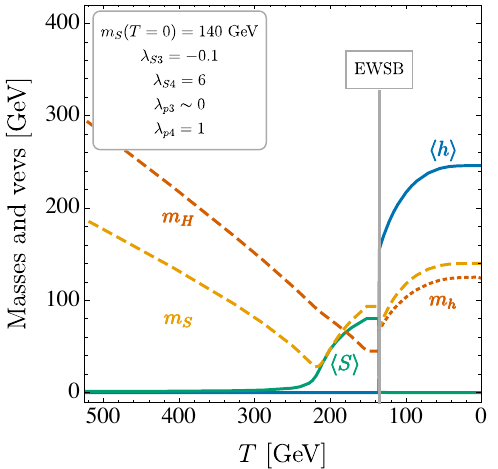
Figure 5 . Evolution of the scalar vevs and masses with temperature for a particular parameter point in the vev-induced DM freeze-in scenario. m H denotes the mass of the SM Higgs doublet above electroweak symmetry breaking, while m h is the mass of the SM-like physical Higgs boson